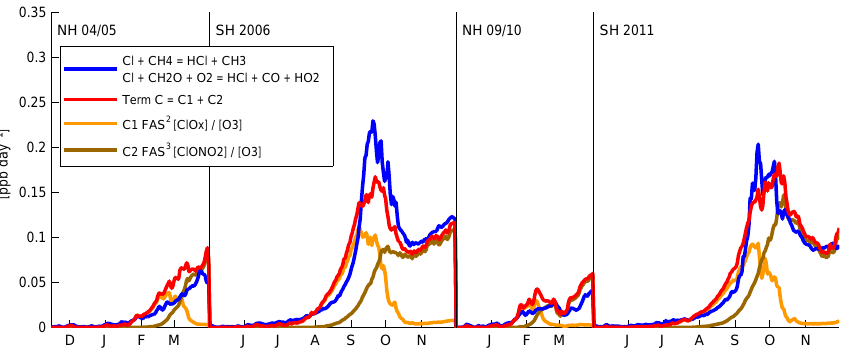
Figure 2. Fit of term C for the Arctic winter 2004/2005, the Antarctic winter 2006, the Arctic winter 2009/2010 and the Antarctic winter 2011 at 54hPa. Sum of the vortex-averaged reaction rates modeled by ATLAS for the reactions Cl + CH 4 and Cl + CH 2 O (blue), the fitted terms C 1 (orange) and C 2 (brown) and the sum C 1 + C 2 (red). Tick marks on the horizontal axis show start of months.